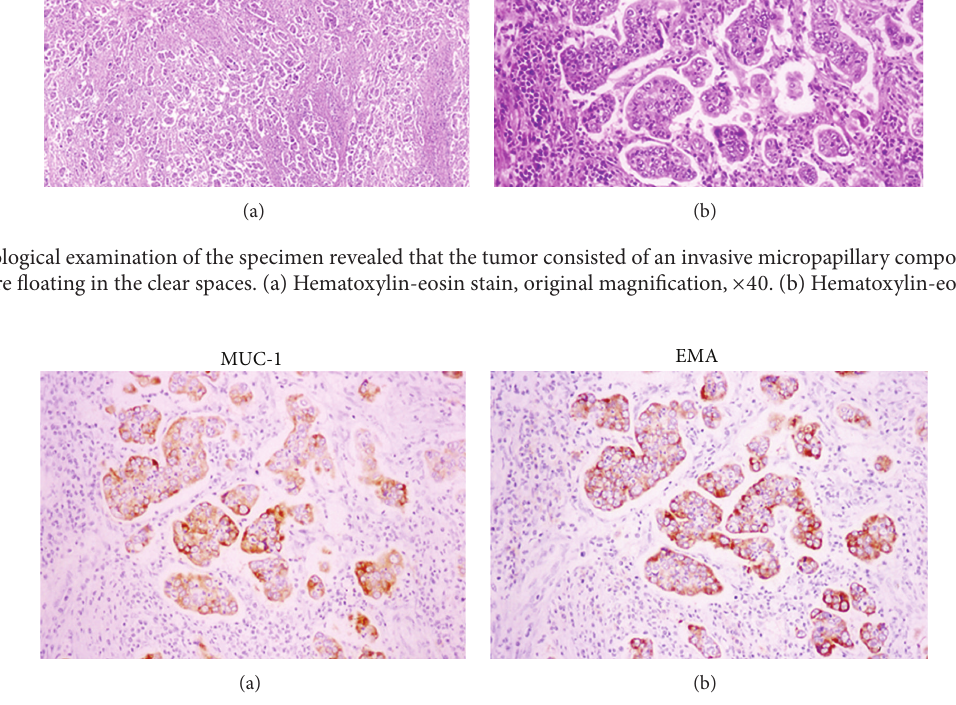
Figure 4: Immunohistochemical staining showed the carcinoma cells to be positive for epithelial membrane antigen (EMA) and MUC-1. Carcinoma cell membranes at the periphery of the cell clusters were characteristically positive for EMA and MUC-1, indicating an “inside- out” pattern of